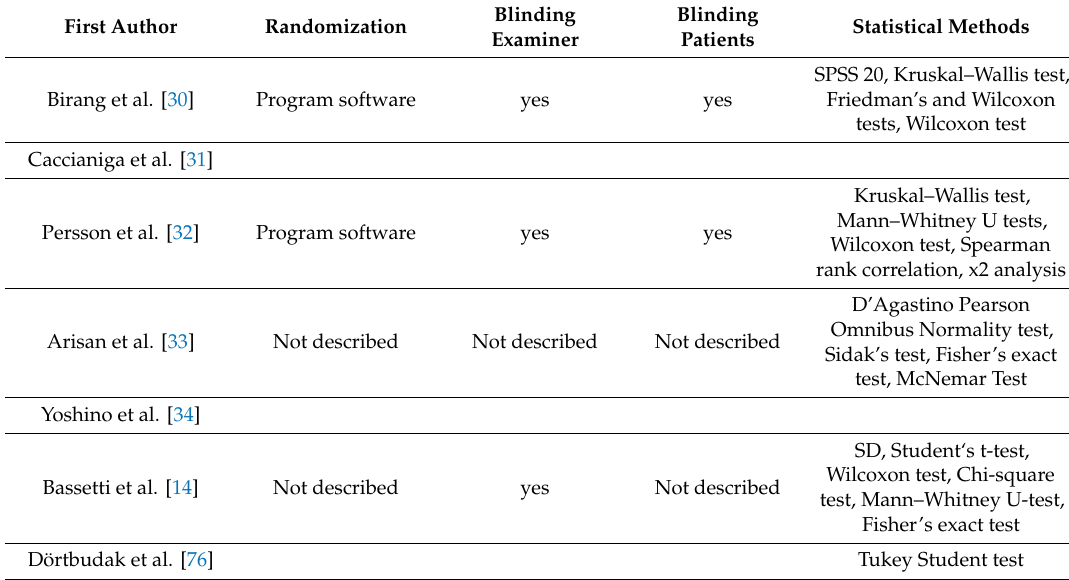
Table 7. Risk of bias across